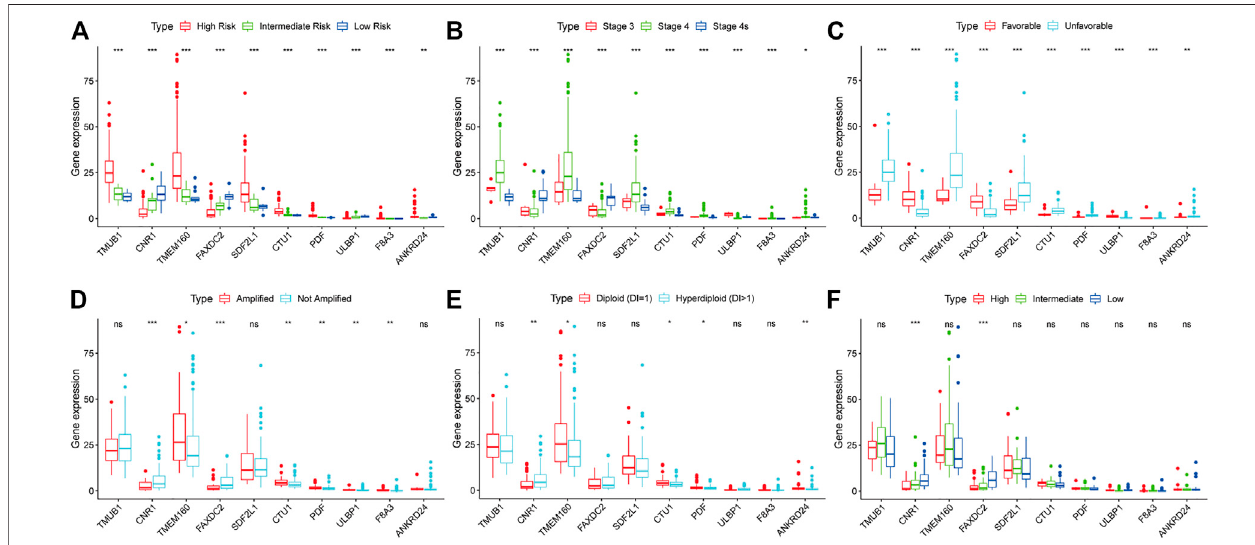
FIGURE4| TherelationshipbetweenthetenRNAsandclinicalcharacteristics.ThecorrelationsoftheexpressionoftengeneswiththeCOGclassi fi cation (A) ,INSS stage (B) , histology group (C) , MYCN ampli fi cation (D) , ploidy status (E) , and MKI (F) . * p < 0.05, ** p < 0.01, *** p < 0.001.